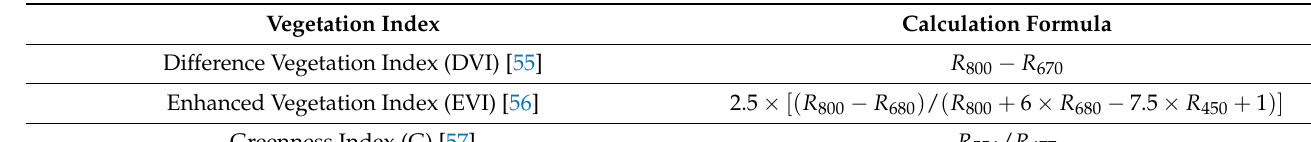
Table 3. List of vegetation indices used in this